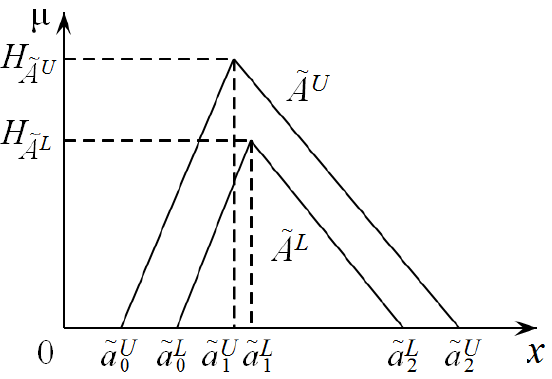
Figure 3. Lower membership function ˜ A L and upper membership function ˜ A U of a triangular interval type-2 fuzzy set ˜ A